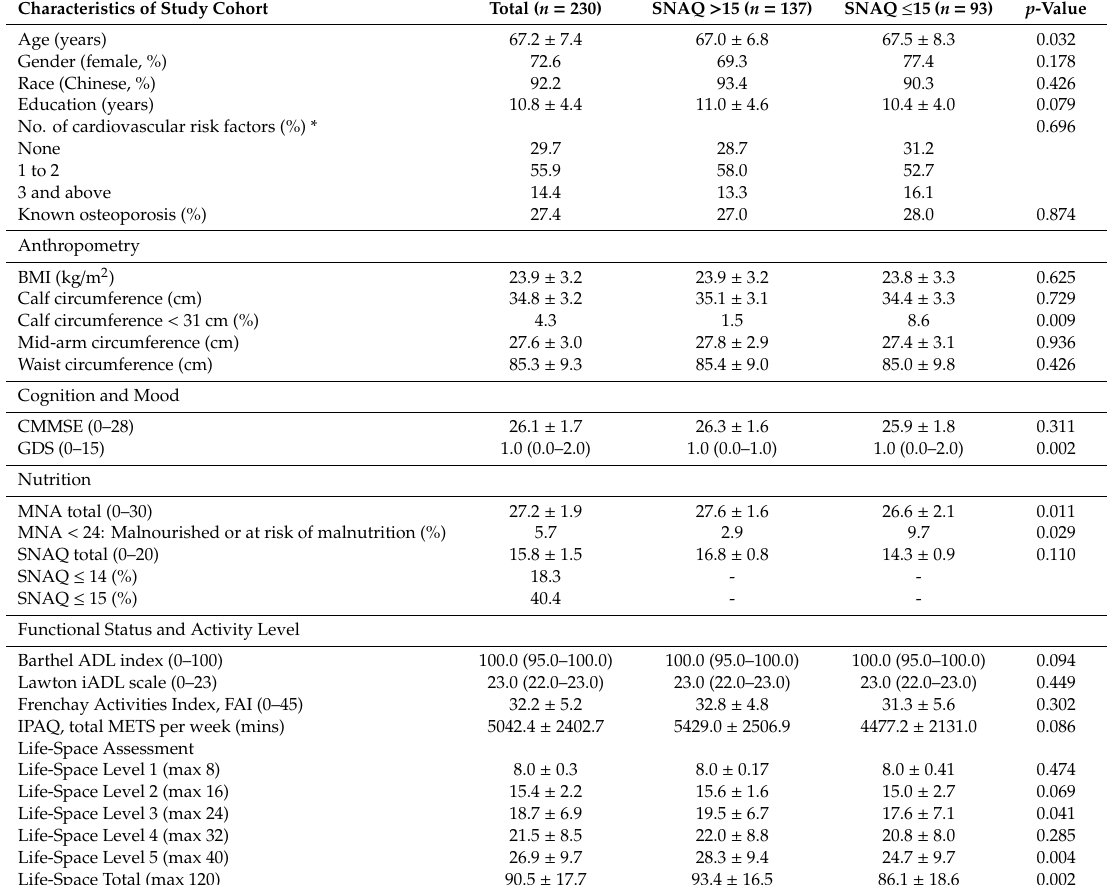
Table 2. Characteristics of Study